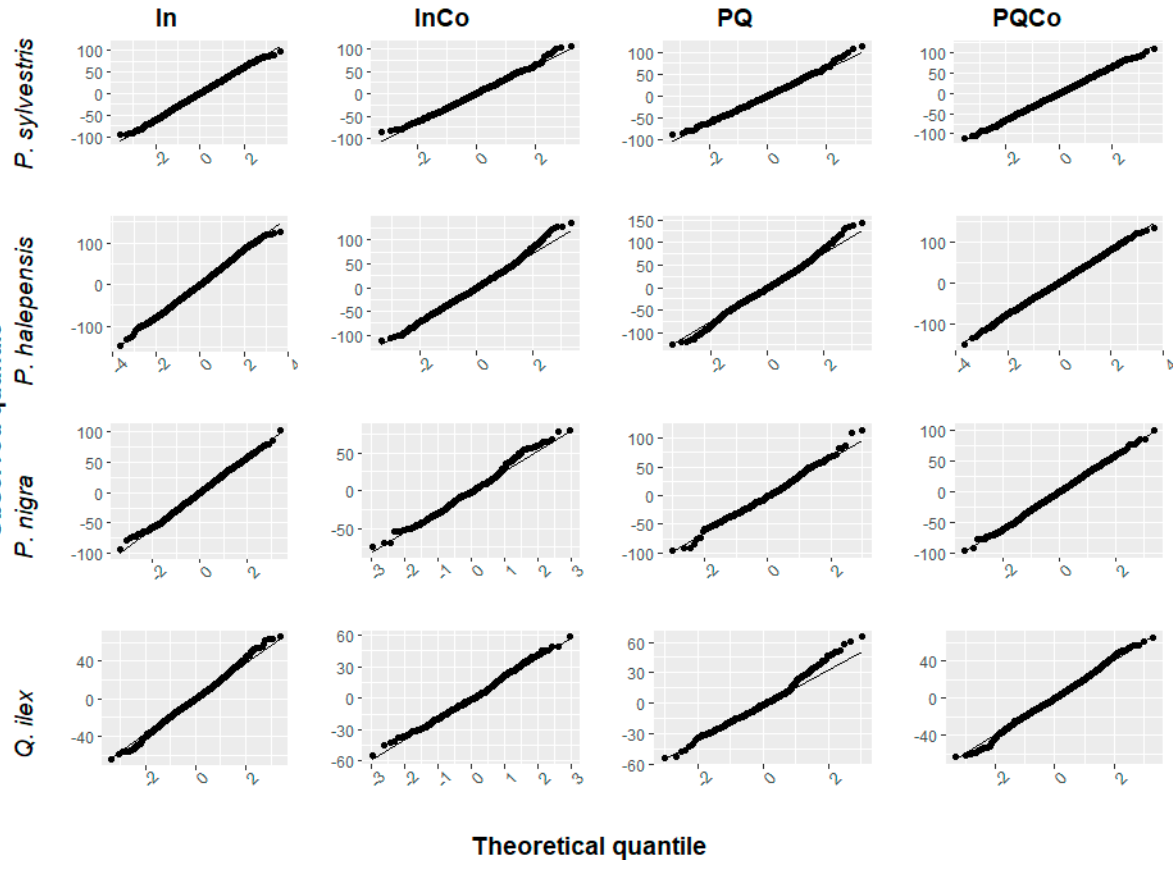
Figure A4. Diagnostic plot (qqplots) of the linear model for observed DBH4 vs. predicted DBH4 with the closest neighbor, plot for each method and species. Table A2. Confidence interval at the 95% level for the intercept and for the slope of the linear model between the observed DBH4 and the predicted DBH4 for untracked trees considering two aggregation levels (individual (In) and plot-quantile classes (PQ)), and Equations (1) and (2) (Co for